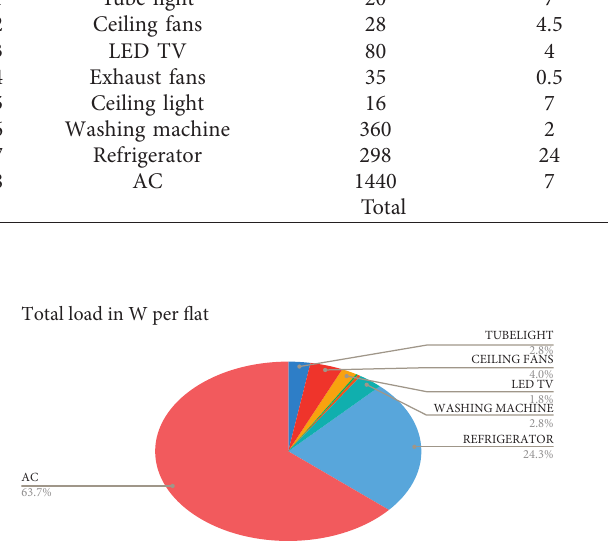
Figure 6: Load distribution—conventional loads—2BHK.